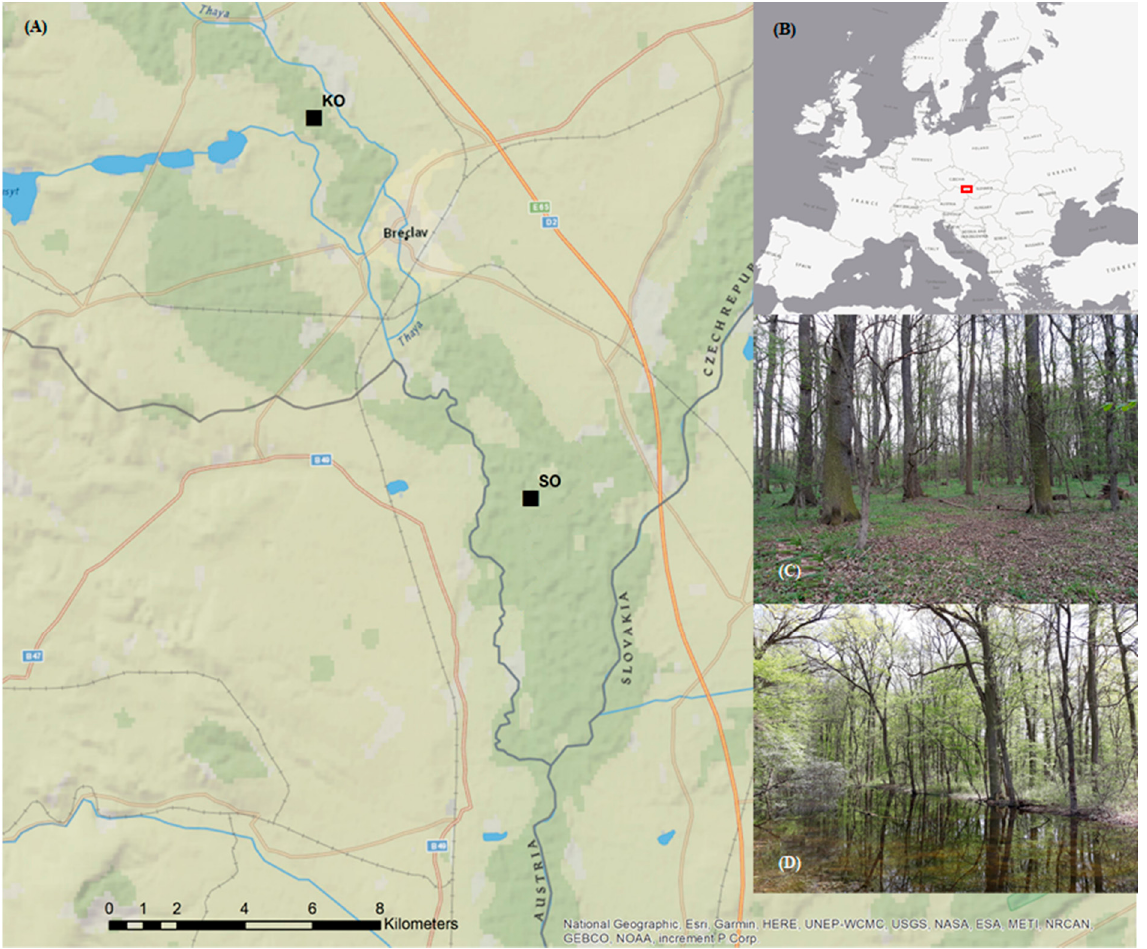
Figure 1. ( A ) The position of studied sites within the study area, ( B ) the location of the study area in Europe. The photographs show: ( C ) SO and ( D ) KO sites in